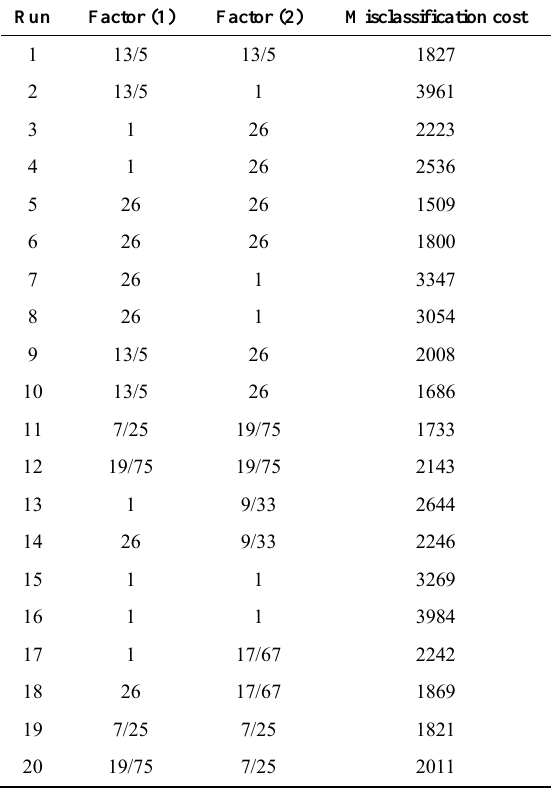
Table 3. Experiments and results for the dataset.